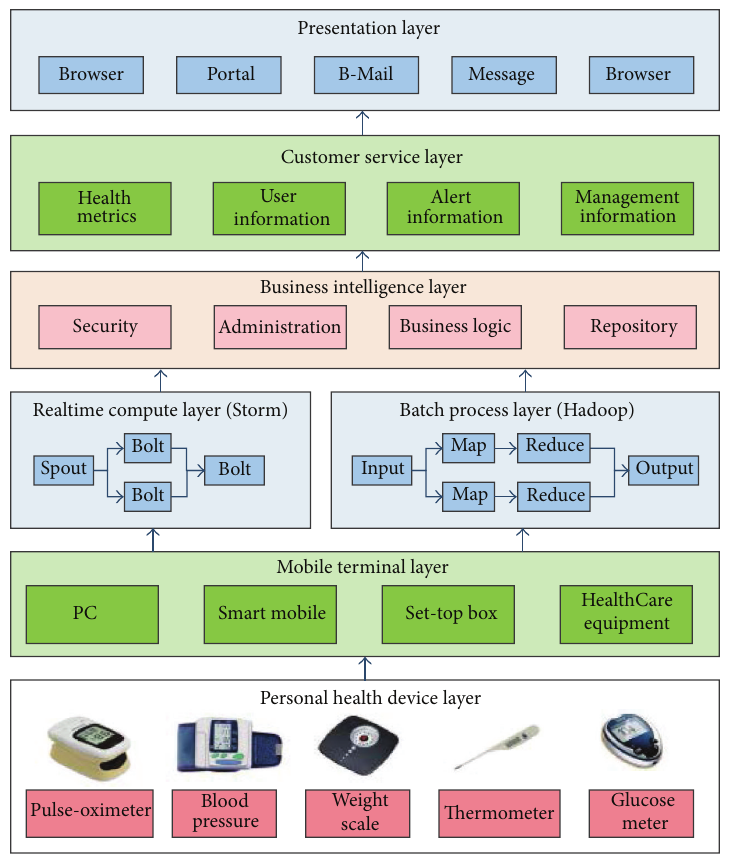
Figure 16: The architecture of the X73 uHealth application.